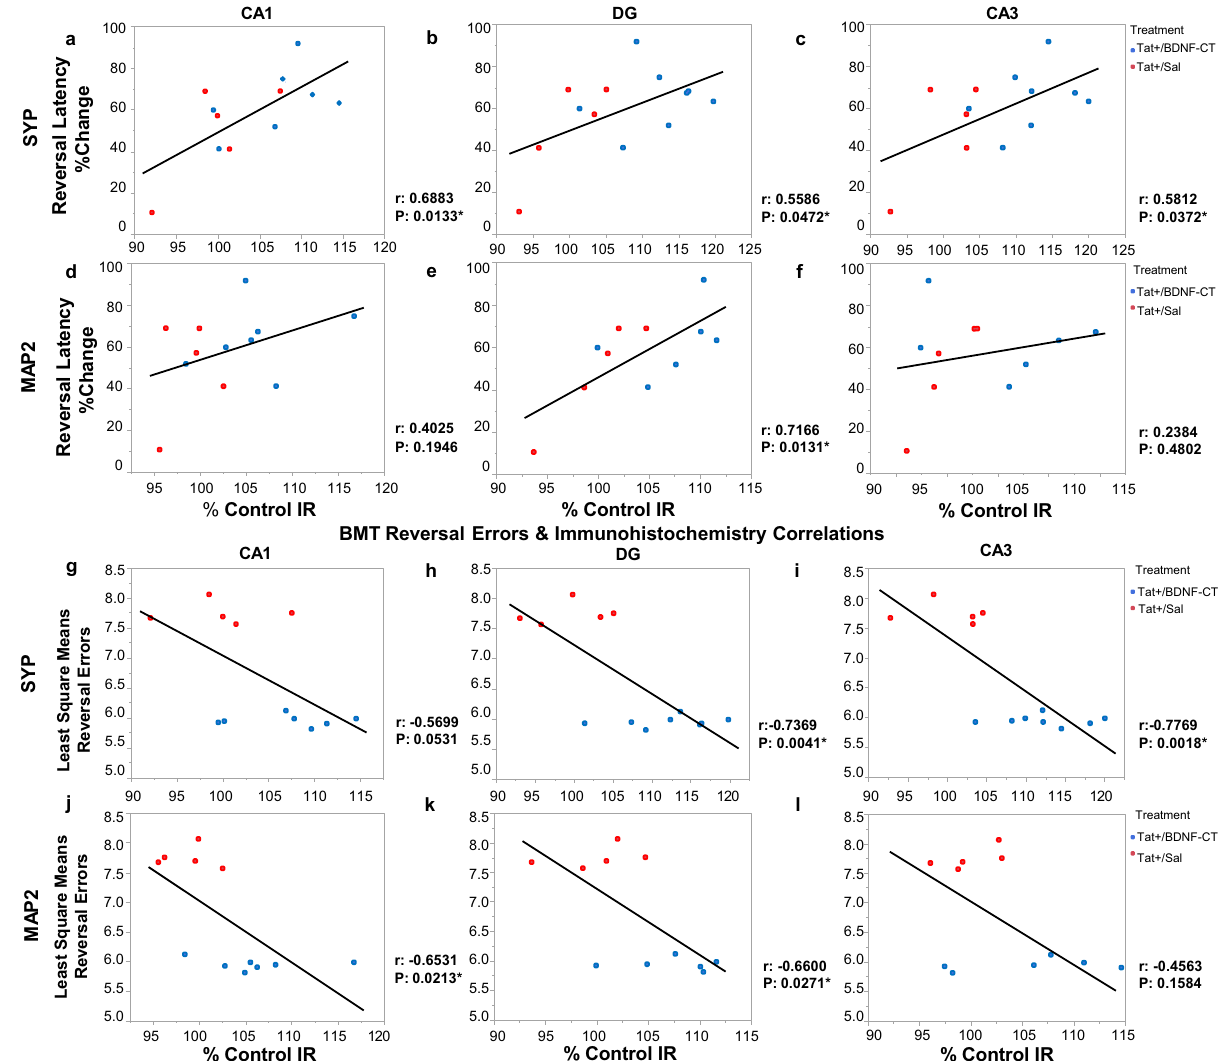
Fig. 8 Improvements in memory and cognitive fl exibility during BMT reversal leaning task are associated with enhanced hippocampal synaptogenesis and dendritic integrity. The mean latency percent change from the maximum time allowed to fi nd an escape hole in the BMT reversal learning phase (reversal latency %Change) versus the mean CA1, DG, and CA3 hippocampal SYP ( a – c ) and MAP2 ( d – f ) immunoreactivities (IR, normalized to Tat + /Sal controls) are shown. The reference errors least square means versus the mean CA1, DG, and CA3 hippocampal SYP ( g – i ) and MAP2 ( j – l ) immunoreactivities (normalized to Tat + /Sal controls) are shown. Correlation Coef fi cients ( r ) were determined by calculating Pearson product-moment correlations for CA1, DG, and CA3 hippocampal regions. Signi fi cant correlations ( P < 0.05) are indicated by